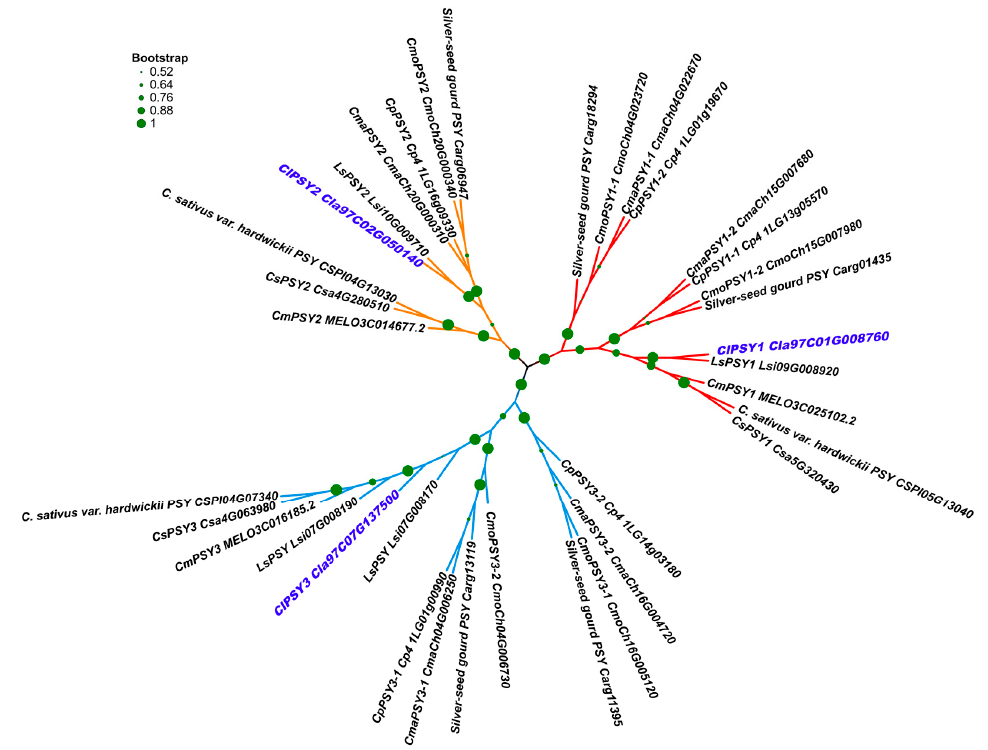
Figure 5. Phylogenetic tree and gene structure of PSY family proteins from various species retrieved from the Cucurbit Genomics Database (http://www.icugi.org/; accessed on 15 January 2022).